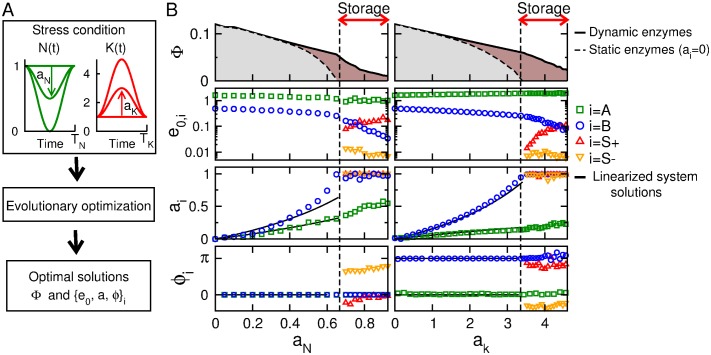
Optimal enzyme profile in the presence of time-dependent nutrient or energy stress.Case where rate coefficients Ei(t) have optimized oscillatory time courses (Eq 6). (A) Simulation protocol to obtain optimal enzyme profiles as a function of the stress condition. (B) Optimal solutions as a function of stress type and amplitude reveal the existence of storage-based solutions for large enough amplitude. Upper panel: Growth rate Φ, mean enzyme levels e0,i, amplitude of enzyme oscillations ai, phase of enzyme oscillations φi. Optimal enzyme profiles obtained with evolution methods (colored points) are compared with small amplitude solutions obtained with perturbation methods (continuous lines).